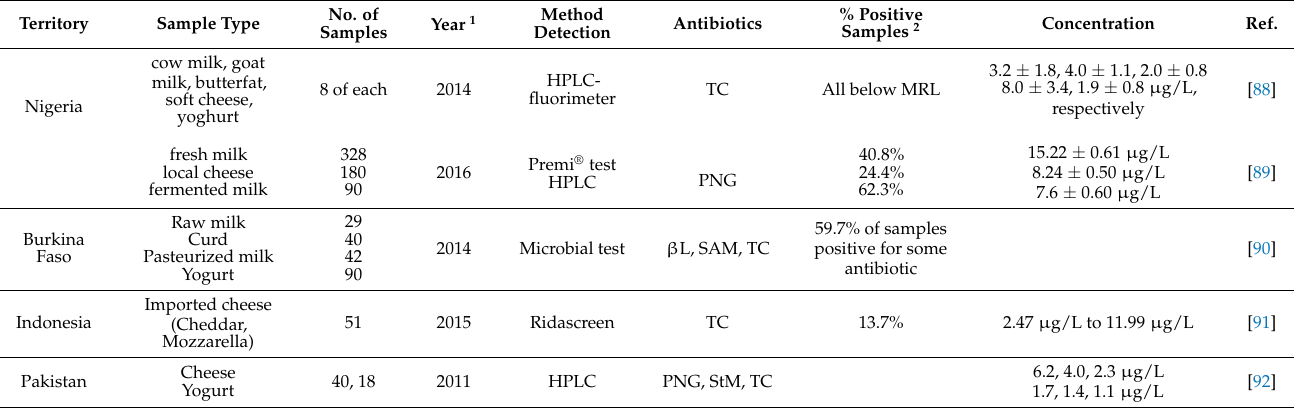
Table 3. Published research works on the detection of antibiotic residues in commercial dairy